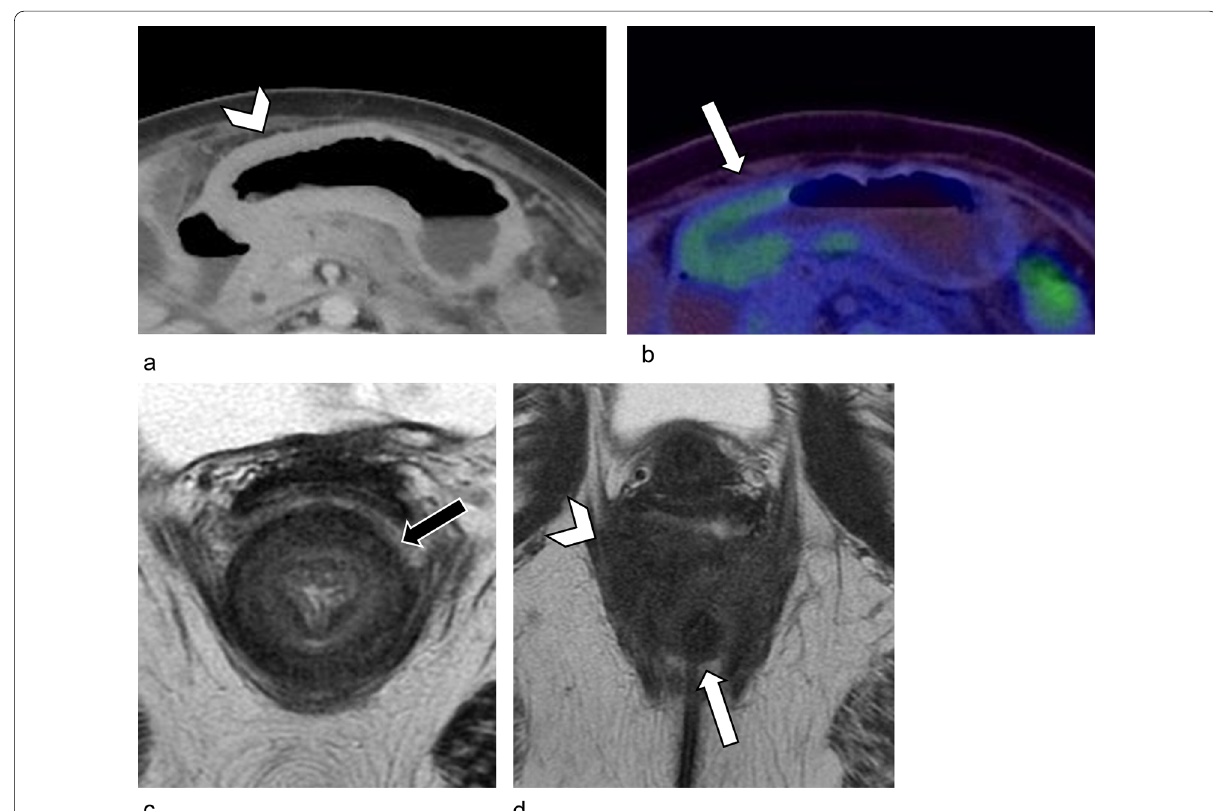
Fig. 7 Linitis plastica appearance of the stomach and rectum due to metastatic ILC in a 61-year-old female. Six years after completing therapy for Stage 1A ILC of the right breast, she presented with change in bowel habit and a palpable rectal mass on examination. She later developed symptoms of subacute bowel obstruction. a Axial contrast-enhanced CT image shows incidental diffuse, circumferential wall thickening of the stomach (white arrowhead), suggestive of linitis plastica. b Corresponding axial PET/CT demonstrates mild 18 F-FDG-uptake (SUVmax 3.05) in the distal stomach (white arrow). This degree of metabolic uptake was deemed at the upper limit of physiological uptake. Diffuse metastatic involvement of the stomach was confirmed on exploratory laparotomy. c Axial T2-weighted MR image demonstrates circumferential thickening of the rectum, with preserved concentric bowel wall layers (black arrow), giving a “target sign” appearance. d Axial T2-weighted MR image of the